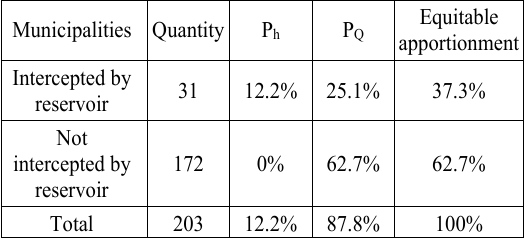
Table 3. Percentage contributions to the total energy produced